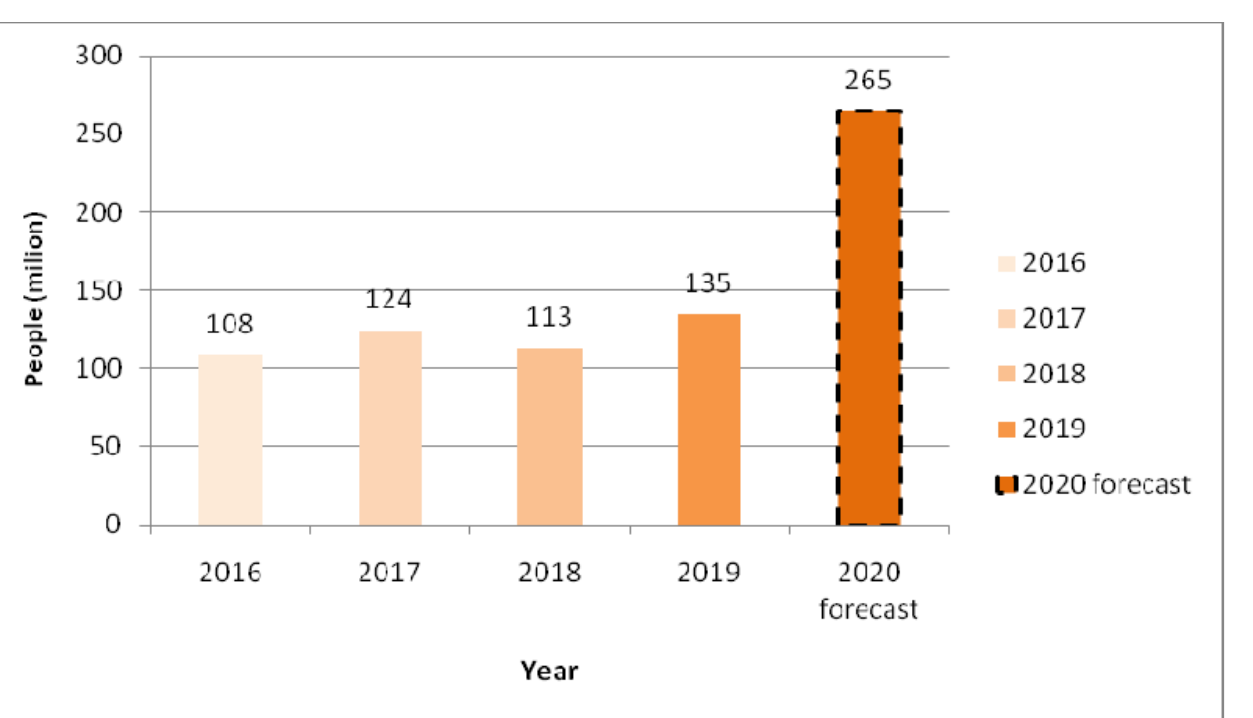
Figure 1. The number of people facing acute food insecurity. Adapted from [5] .